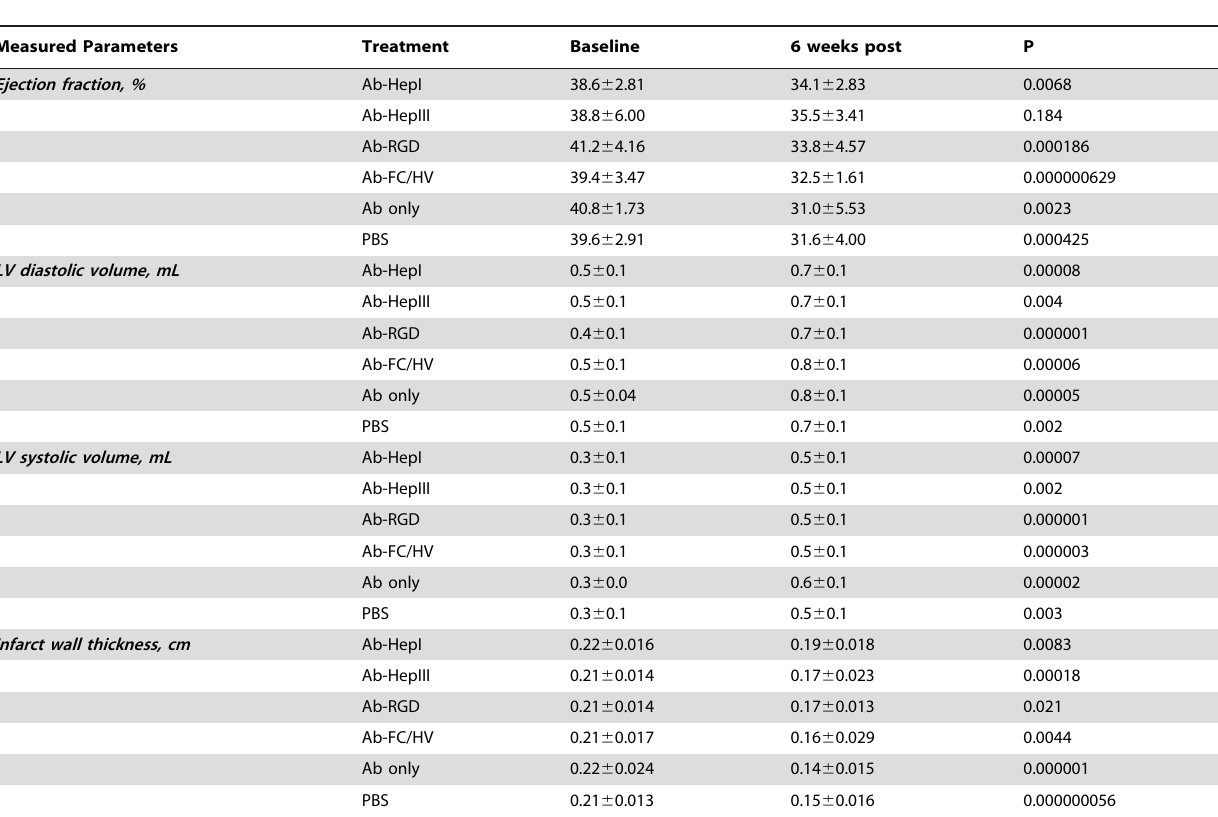
Table 2. Echocardiography data showing the internal comparisons between measurements taken before injection (baseline) and 6 weeks after